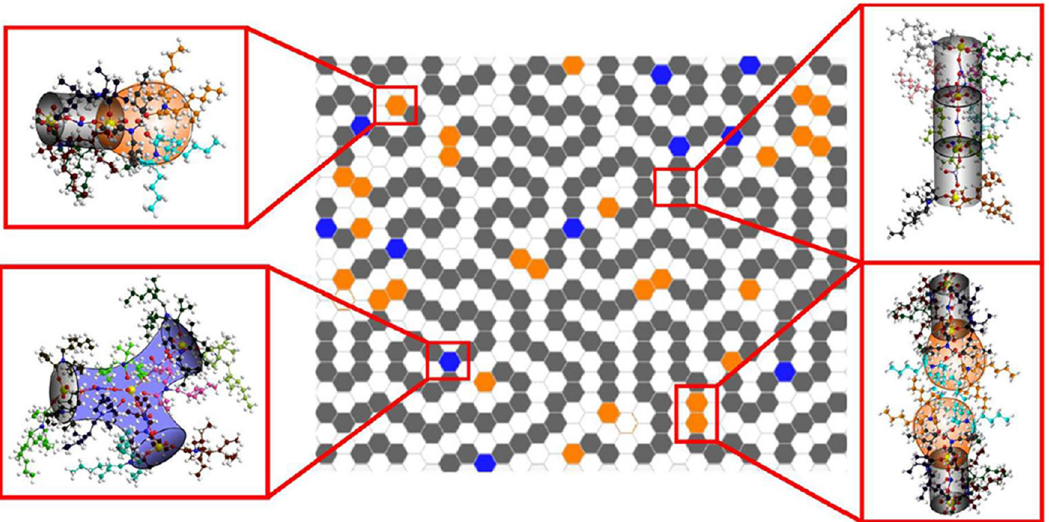
Fig. 3. 2D model using an hexagonal grid with endcaps (orange), cylinders (grey) and junction